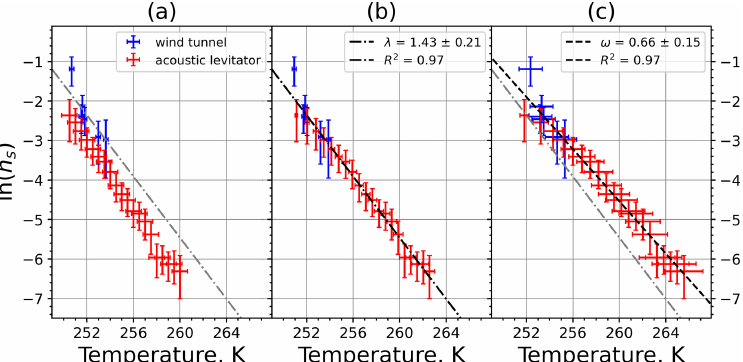
Figure A10. (a) Composite INAS density spectrum of montmorillonite from the uncorrected M-WT (blue) and M-AL (red) measurements. Panels (b) and (c) show the temperature-corrected data points from the M-WT and M-AL experiments based on λ and ω , respectively. The dash-dotted line in (c) is the regression line on corrected data points obtained by employing the optimal λ value as in (b)